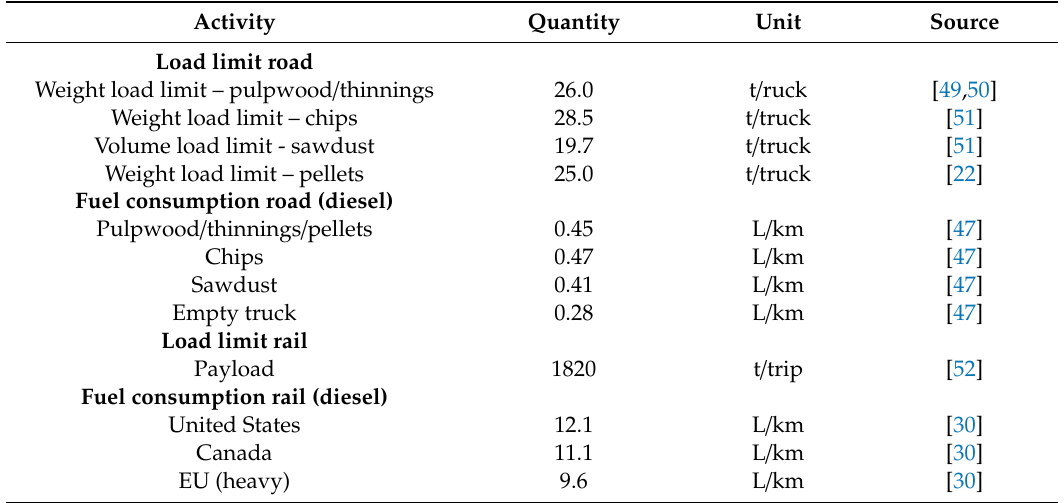
Table 3. Data used for calculation of costs and emissions of truck transport of forestry